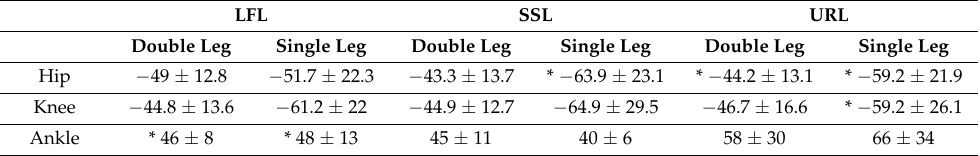
Table 2. Descriptive statistics and results of 2-way repeated measure ANOVAs (Mean ± SD) compar- isons of sagittal plan trunk angles (LFL, SSL and URL) and hip, knee and ankle flexion angles during double/single-leg landing.